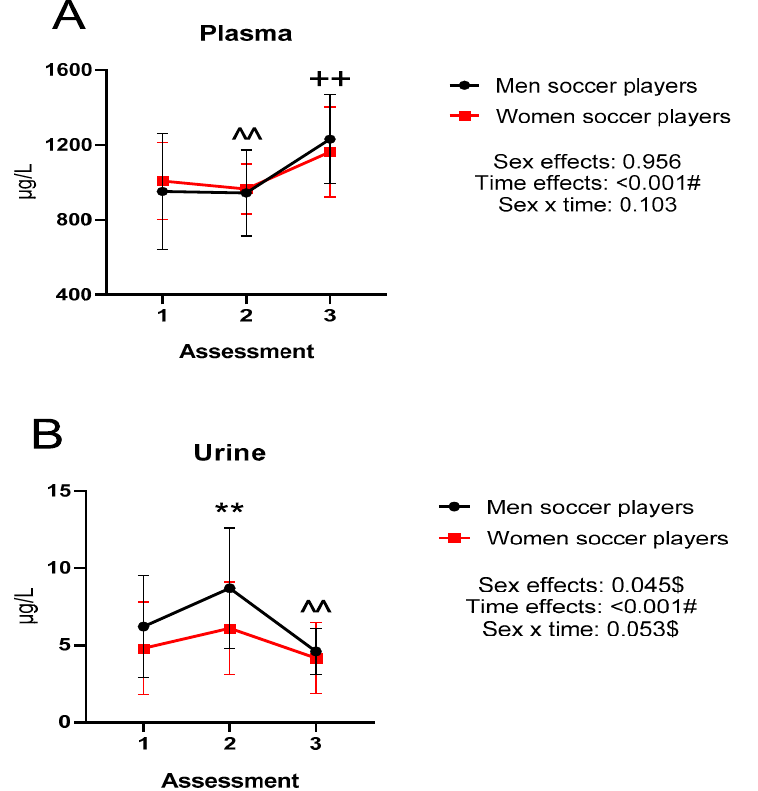
Figure 1. ( A ) plasma Cu concentrations; ( B ) urinary Cu concentrations; # large effect size (>0.14); $ moderate effect size (0.06–0.14); ** p <0.01 differences between 1st and 2nd assessment; ++ p <0.01 differences between 1st and 3rd assessment; ^^ p < 0.01 differences between 2nd and 3rd assessment; Cu: copper. Figure 2 represents the intracellular concentrations (erythrocytes and platelets), in absolute values and relative to the number of cells, throughout the investigation. There were sex differences in erythrocyte and platelet Cu concentrations expressed in relative values ( p < 0.01). As for differences throughout the study, there were differences in abso ‐ lute Cu concentrations in both platelets and erythrocytes ( p < 0.01). In erythrocytes (A), there were differences between titration 1 and 2 ( p < 0.01), while in platelets (C) there were differences between titration 1 and 3 ( p < 0.01).